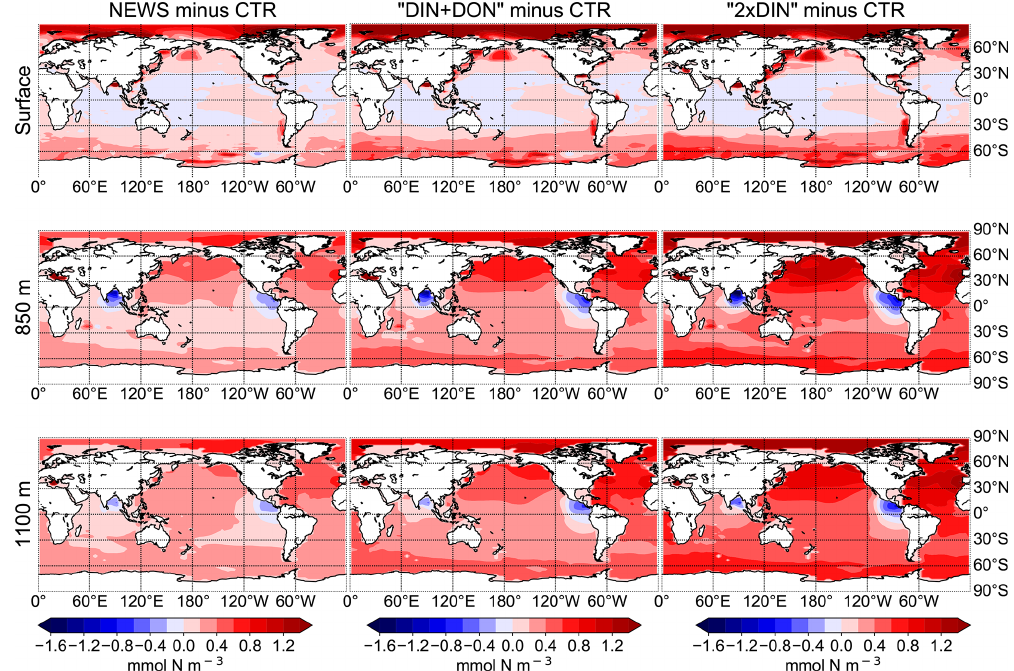
Figure 6. Difference in global distribution of NO 3 concentrations between experimental simulation and the control simulation inmmolNm − 3 . The different simulations are NEWS, DIN + DON, and 2 × DIN. The differences are shown at three different depths: surface (top), 850m (middle), and 1100m